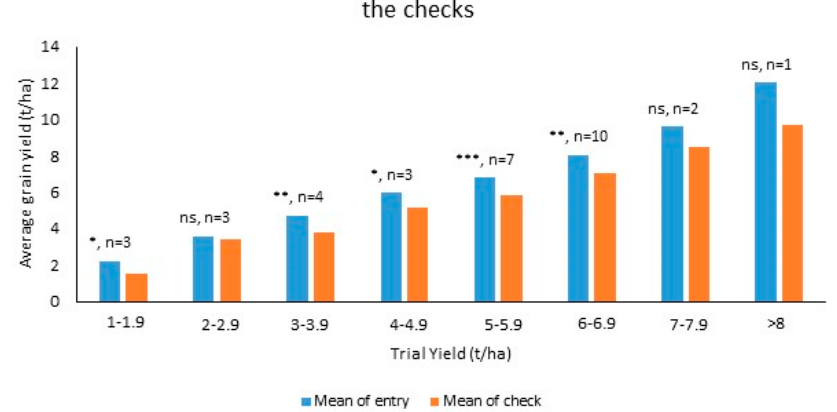
Figure 5. Performance comparison of the top 10 percent entries in comparison to commercial checks during 2015 to 2017 spring season. n-number of hybrids included for comparison, *, **, ***—Significant at 5%, 1% and 0.1%, ns-non significant